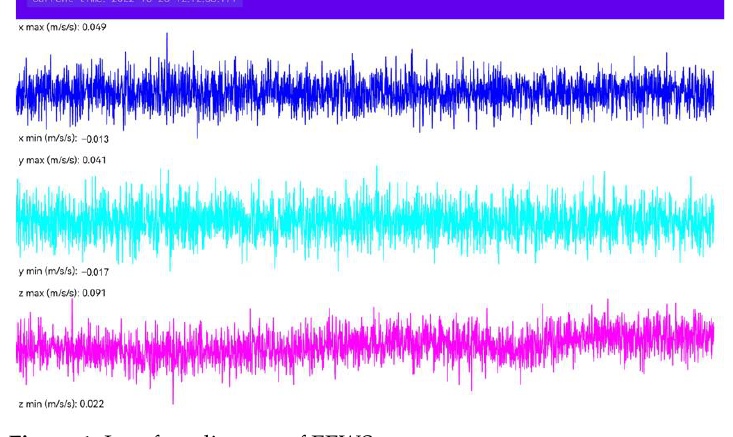
Figure 1. Interface diagram of EEWSensor.